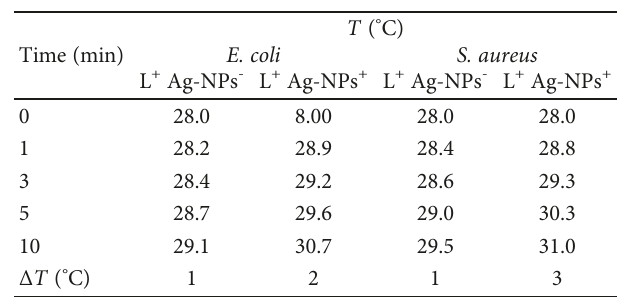
Table 1: Changes in temperature of bacterial suspensions after irradiation with 410nm light.